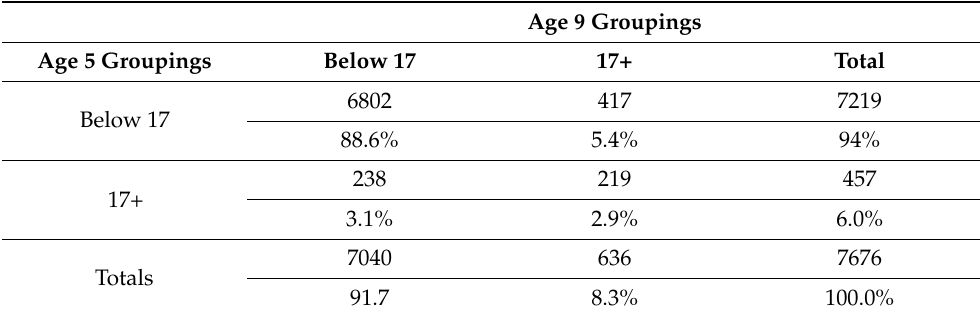
Table 1. The number and percentage of children in the subgroupings based on SDQ